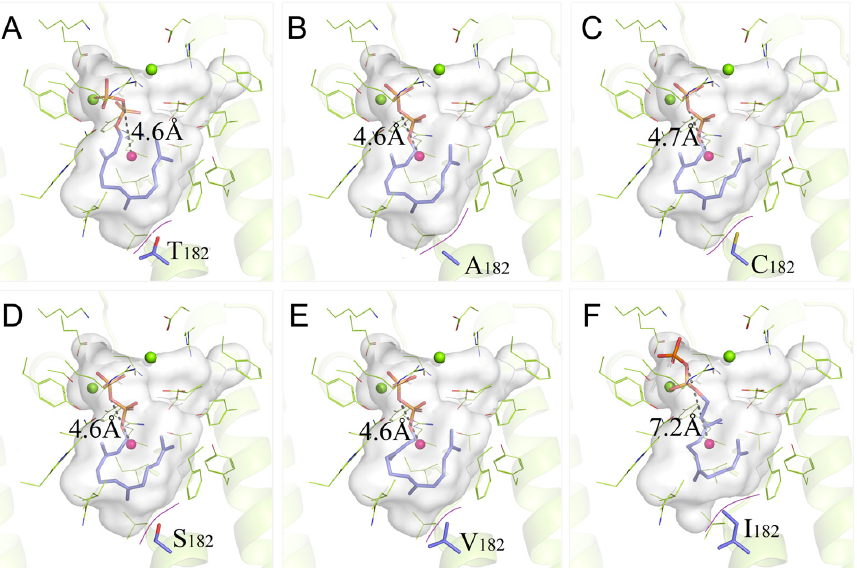
Figure 5. Binding pattern comparisons of PentS–FPP complexes. ( A – F ) are the simulation diagrams showing FPP conformations in the active cavities of the wild type (T182), T182A, T182C, T182S, T182V, and T182I variants, respectively. The secondary structures of wild type and variants of PentS are shown as cartoon and lemon colored. The binding cavities are outlined by white surfaces. The residues at position 182 are shown as sticks in which atoms are color-coded as follows: C, blue; N, dark blue; O, red; S, yellow. The geometric center of the binding cavity of the wild-type PentS (red sphere) was used as a comparing template, and the D O-C is marked with black dashed lines.